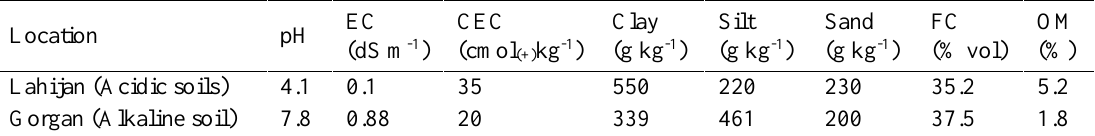
Table1. Some selected characteristics of the studied